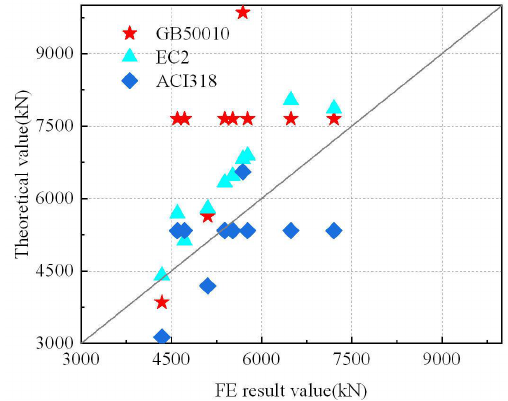
Figure 19. Comparison of FE results with design codes.